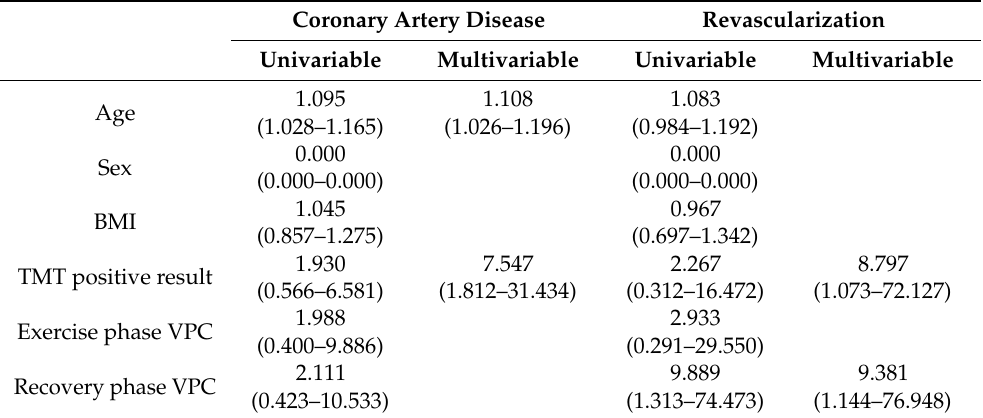
Table 3. Risk for CAD and revascularization in exercise provoked VPC group ( n = 200). Coronary Artery